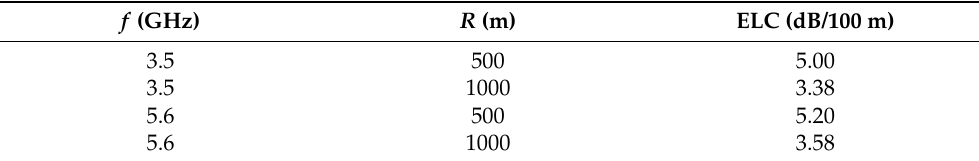
Table 7. Calculation of ELC using empirical